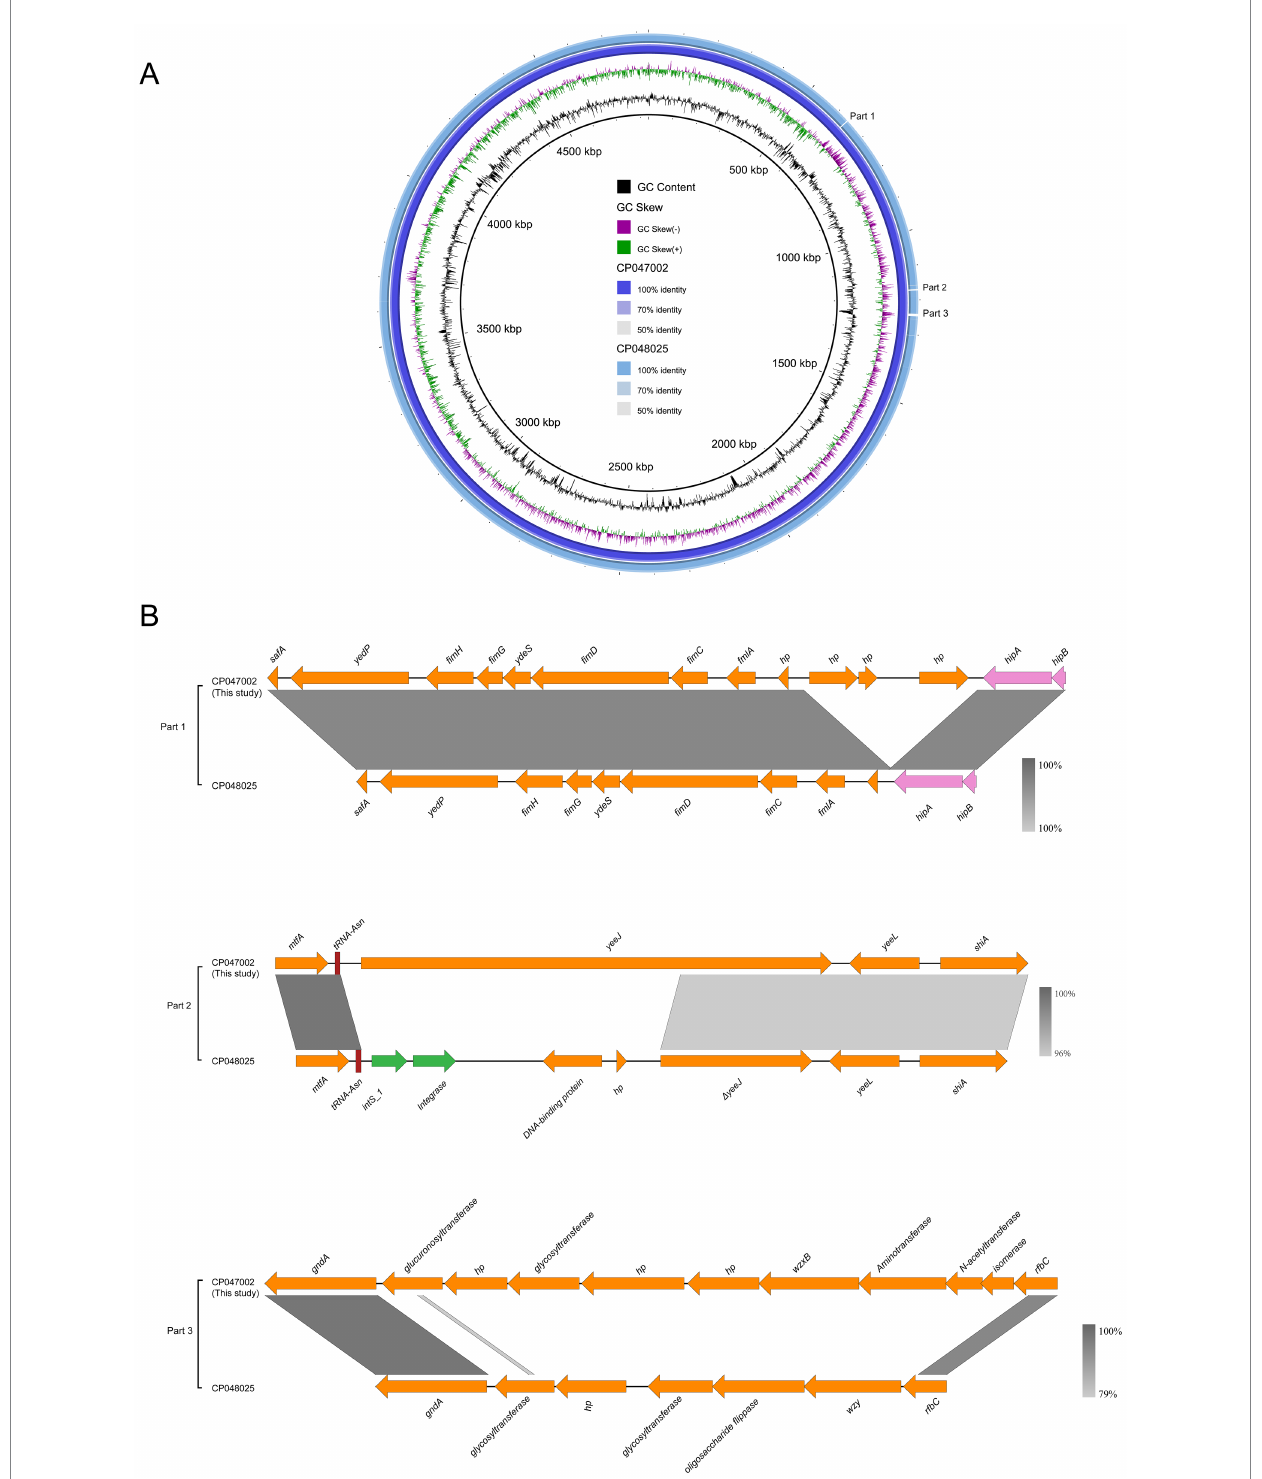
FIGURE 4 Comparative genomic analysis of mcr-1 -carrying chromosome in ST156 J-8 (CP047002, this study) against Escherichia coli ST156 GZEC065 (CP048025) (A) . The chromosome of E. coli J-8 was used as a reference sequence. Colinear sequence comparison of Part 1, Part 2, and Part 3 with J-8’s and GZEC065’s chromosomes (B) . Boxed arrows represent the position and transcriptional direction of ORFs. Dark grey shading denotes regions of homology (>99% identity nucleotide identity). Orange colors represent other genes; pink colors represent the genes associated with type II toxin- antitoxin (TA) system; green colors represent the genes coding integrase ( int